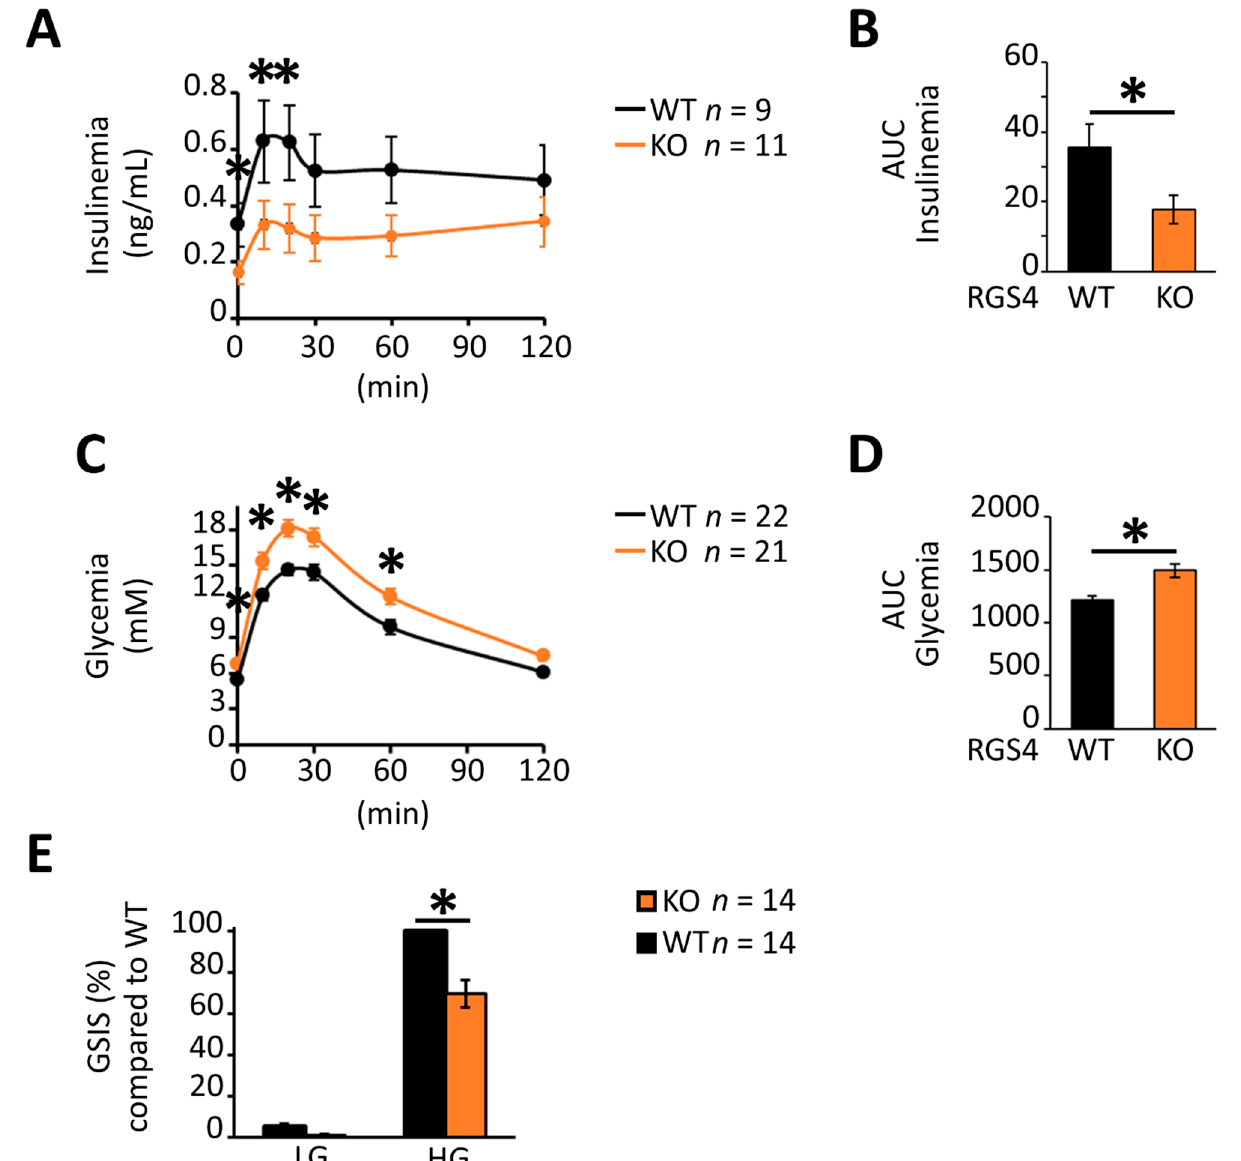
Figure 2. RGS-deficient islets show decreased glucose-stimulated insulin secretion (GSIS) in vivo and in vitro. ( A – D ) Kinetic profiles and corresponding area under the curve (AUC) data for serum insulin ( A , B ) and glycemia levels ( C , D ) following oral glucose challenge of fasted WT and RGS4-deficient mice. Panels C and D correspond to combined analysis of ~2:1 ratio of male to female mice. ( E ) GSIS on isolated islet preparations. Isolated islets from WT and RGS4-deficient mice were treated with 5.6 mM (low glucose, LG) or 20 mM (high glucose, HG) for 30 min and the total secreted insulin determined from the supernatant. Data are expressed as GSIS% relative to that for WT islets challenged with 20 mM glucose. * p < 0.05; [ t -test], ( C , D ) one-way ANOVA and Tukey’s post-hoc test, ( A , C ) two-way ANOVA and Tukey’s post-hoc test ( E )].